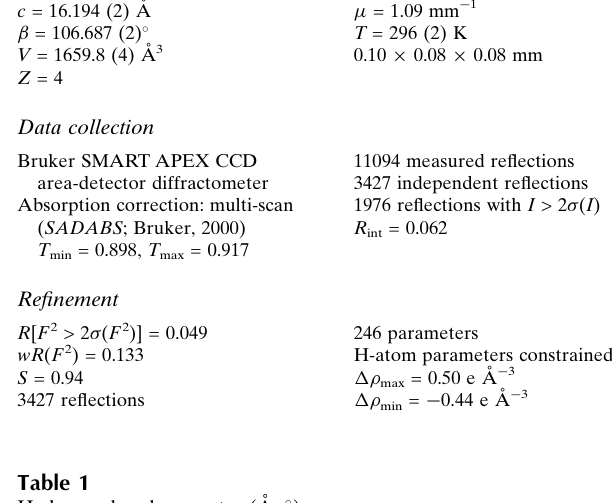
Hydrogen-bond geometry (A˚ , (cid:2)